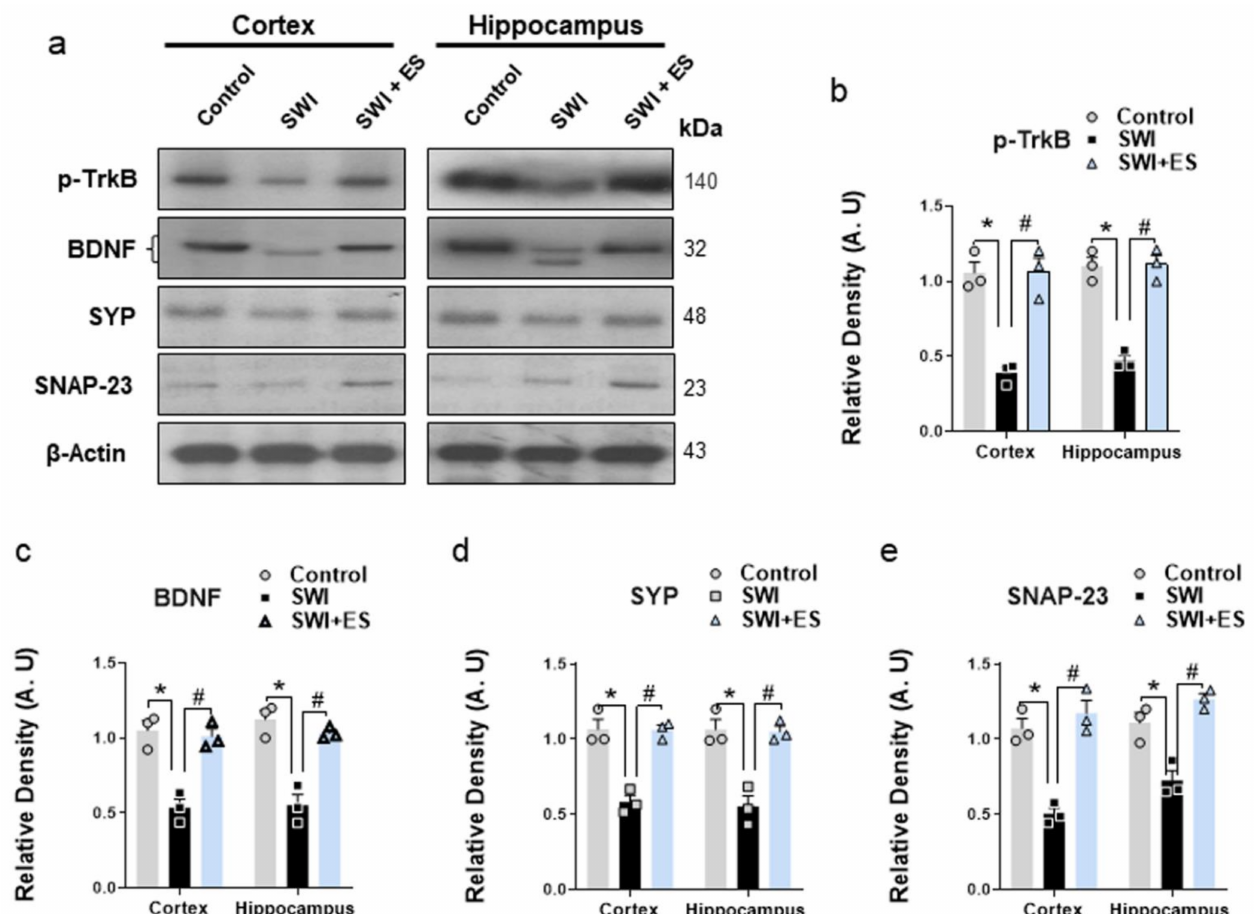
Figure 5. 17- β estradiol improves neurotrophic and synaptic functions after SWI. ( a–e ) Western blot analysis showing the protein expression of p-TrkB, BDNF, SNAP-23, and SYP in the experimental groups. Anti- β -actin was used as a control for protein levels across the samples. The densities are expressed in arbitrary units (AU). Values are presented as means ± S.E.M. The data presented are relative to the control group. p -value < 0.05 was considered significant. * p < 0.05 vs. control group, # p < 0.05 vs. SWI + 17- β estradiol group. Bar = 50 µ m. Statistical significance was determined by one-way analysis of variance (ANOVA) followed by Tukey’s post-hoc analysis using the GraphPad Prism (ver. 8.0.2)